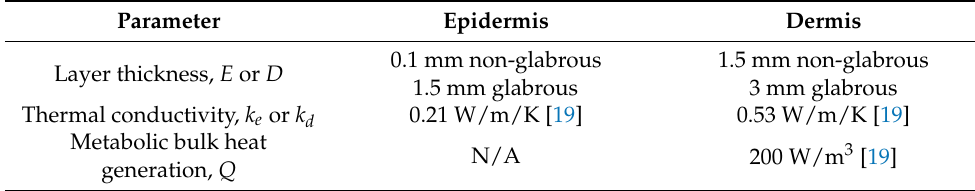
Table 1. The values of model parameters with their